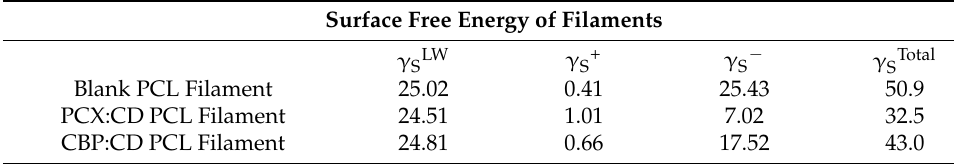
Table 3. Surface free energy data of blank and drug loaded filaments ( n = 6).